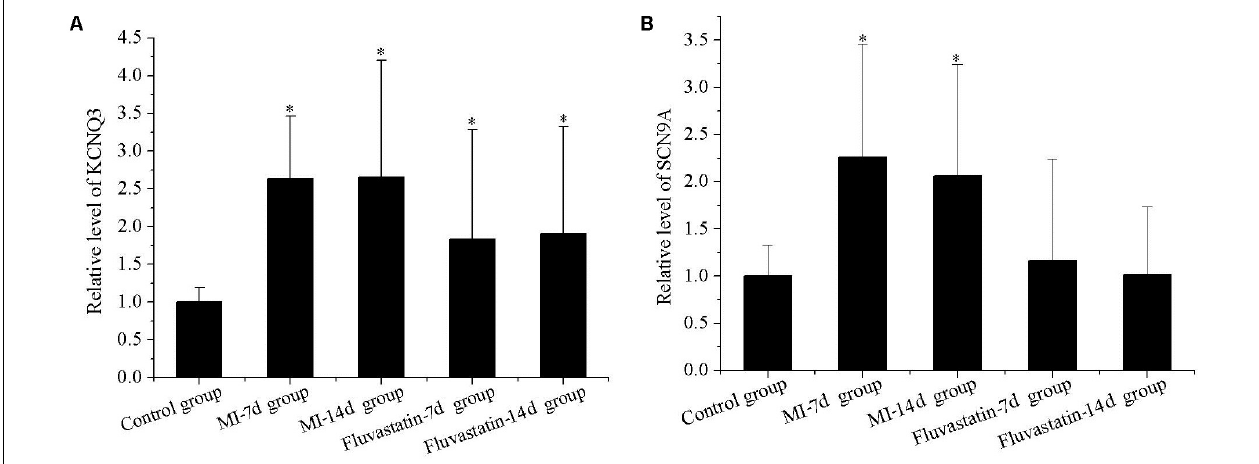
FIGURE 3 | Effects of MI and fluvastatin on mRNA expression of channel protein in SCG neurons. (A) Effects of MI and fluvastatin on KCNQ3 expression. (B) Effects of MI and fluvastatin on SCN9A expression. Each point represents mean ± SD. ∗ P < 0.05 compared with control group.